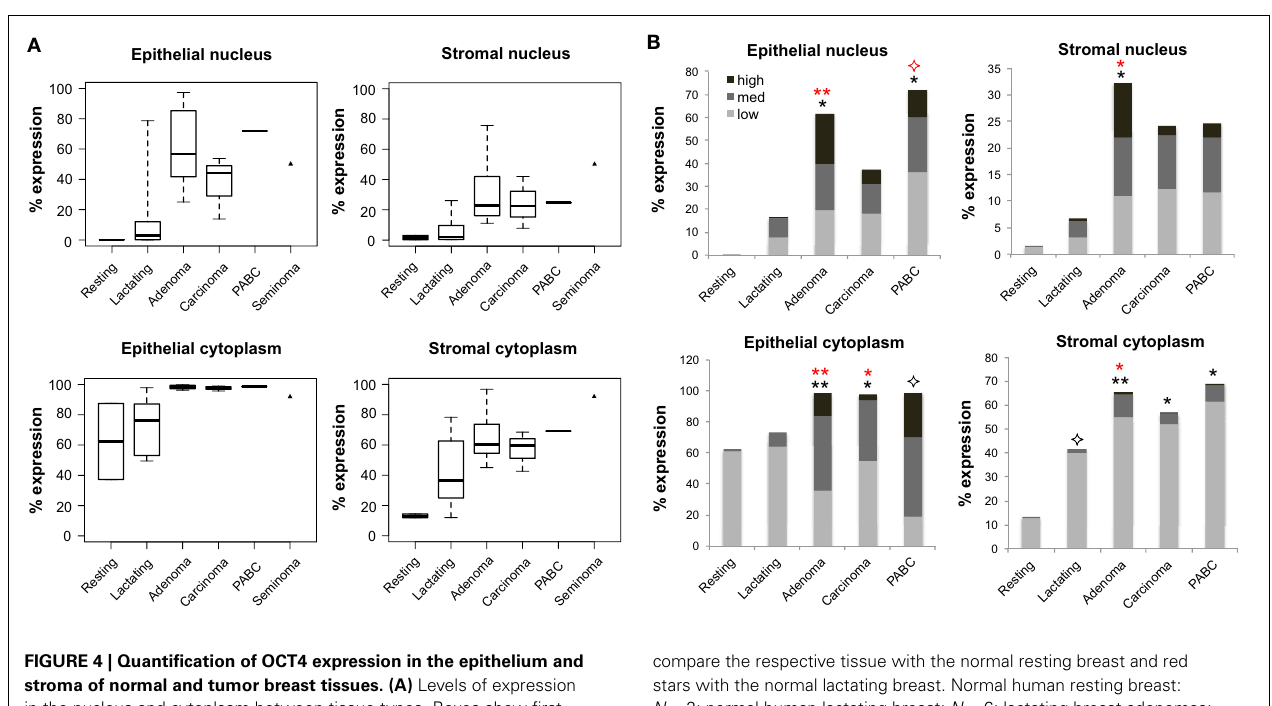
FIGURE 4 | Quantification of OCT4 expression in the epithelium and stroma of normal and tumor breast tissues. (A) Levels of expression in the nucleus and cytoplasm between tissue types. Boxes show first and third quartiles, horizontal bars within boxes indicate median values, and “whiskers” show the range of values. Seminoma was used as positive control. (B) Column charts showing contribution of the different expression levels (low, medium, and high) to the total expression for each tissue type. Significance is shown with stars, whereby black stars